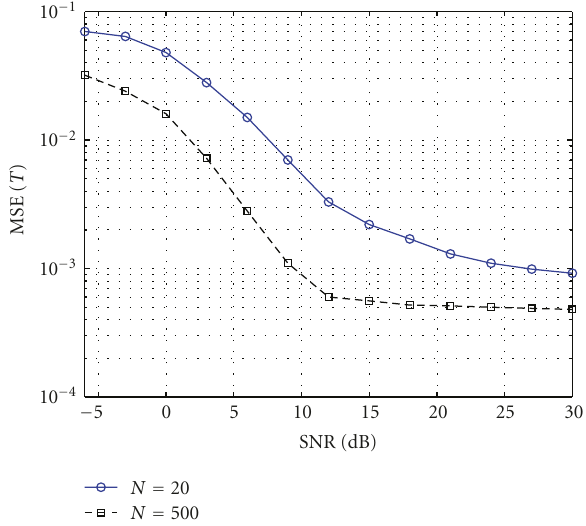
Figure 8: The synchronization error of the JVSS algorithm with various frame sizes, N = 20 and N = 500,